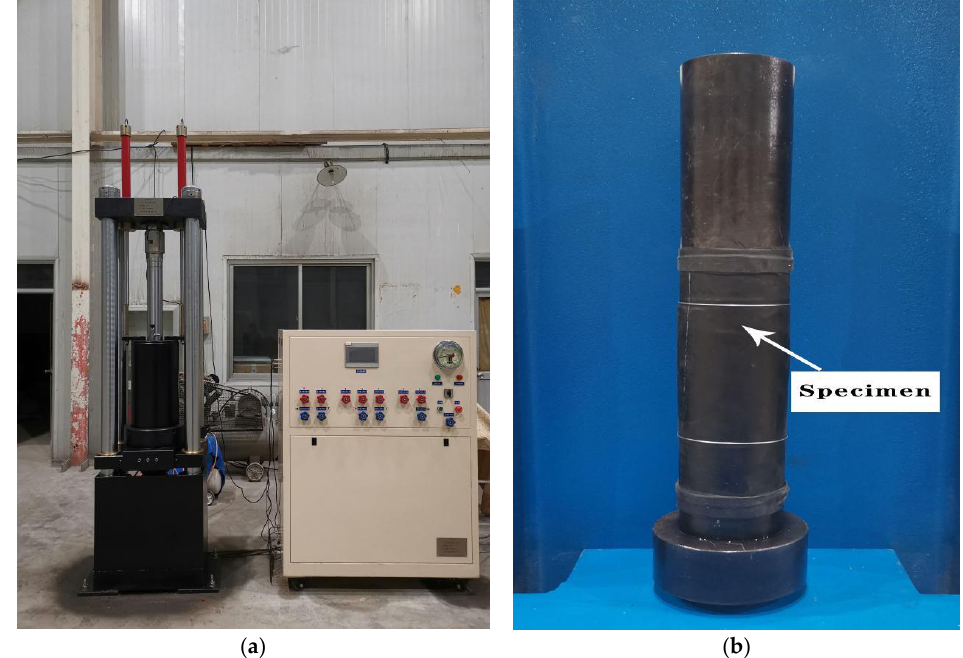
Figure 3. Loading device and specimen: ( a ) Loading device; ( b ) Specimen wrapped with thermoplastic